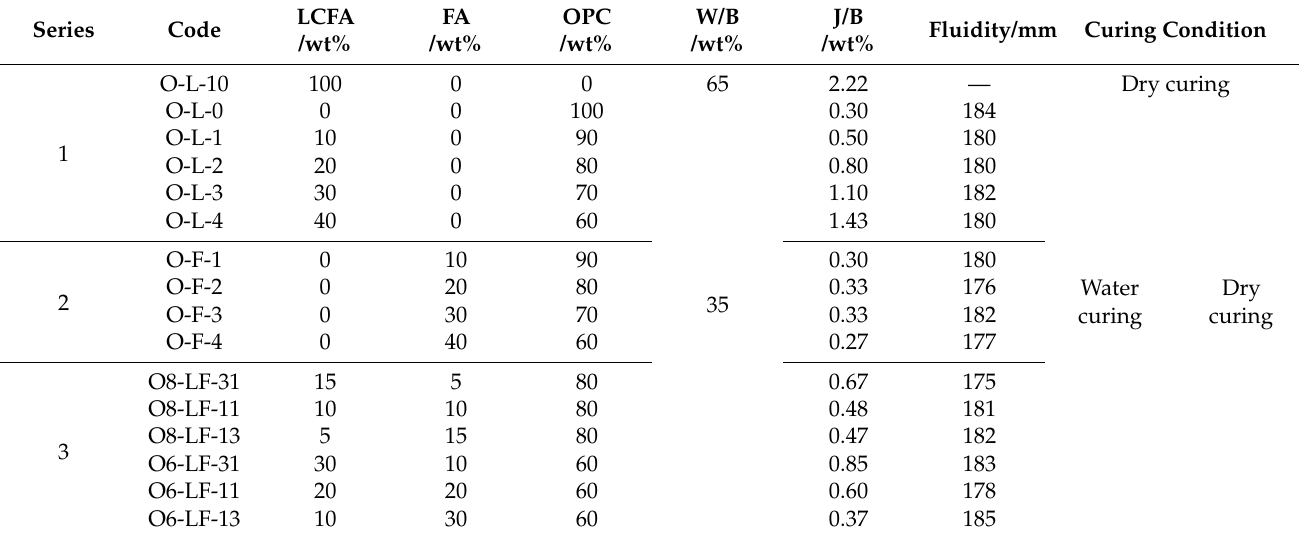
Table 2. Experimental mix proportion and the fluidity